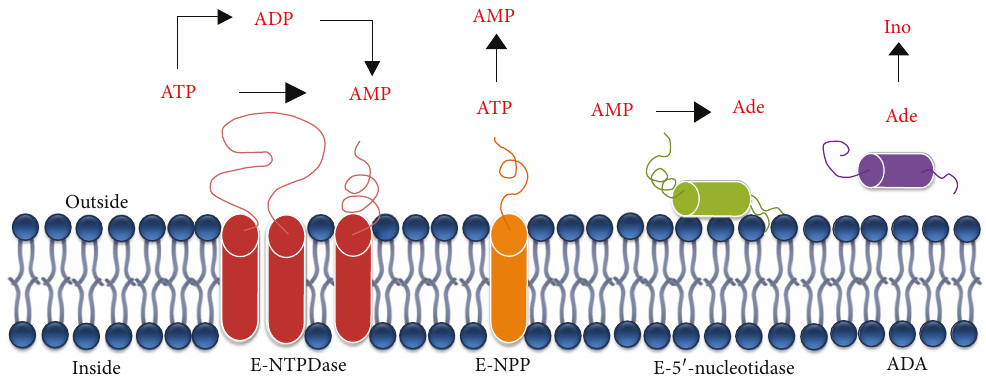
Figure 1: Cell membrane-anchored ectonucleotidases and their respective hydrolysis